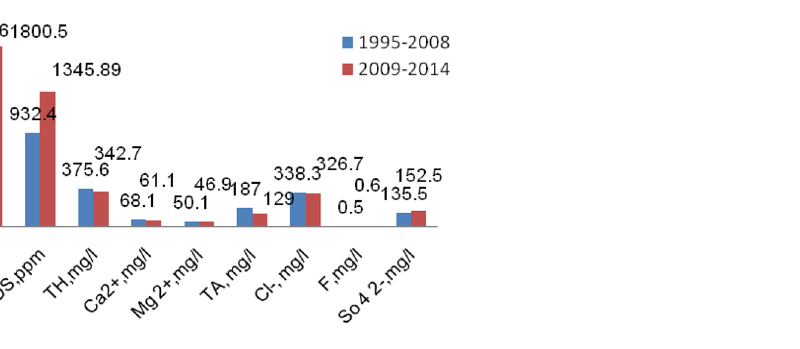
Figure 6. Comparison between the mean value